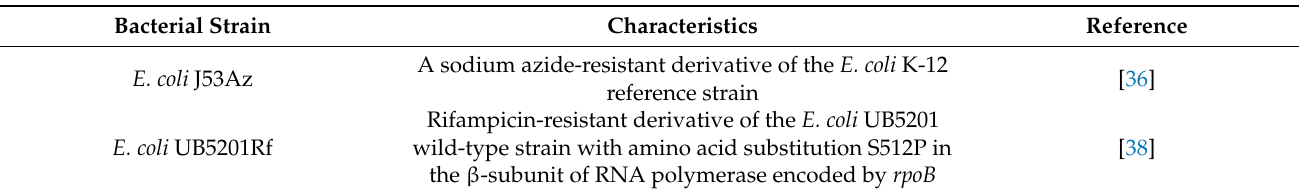
Table 2. E. coli host strains used in this study.